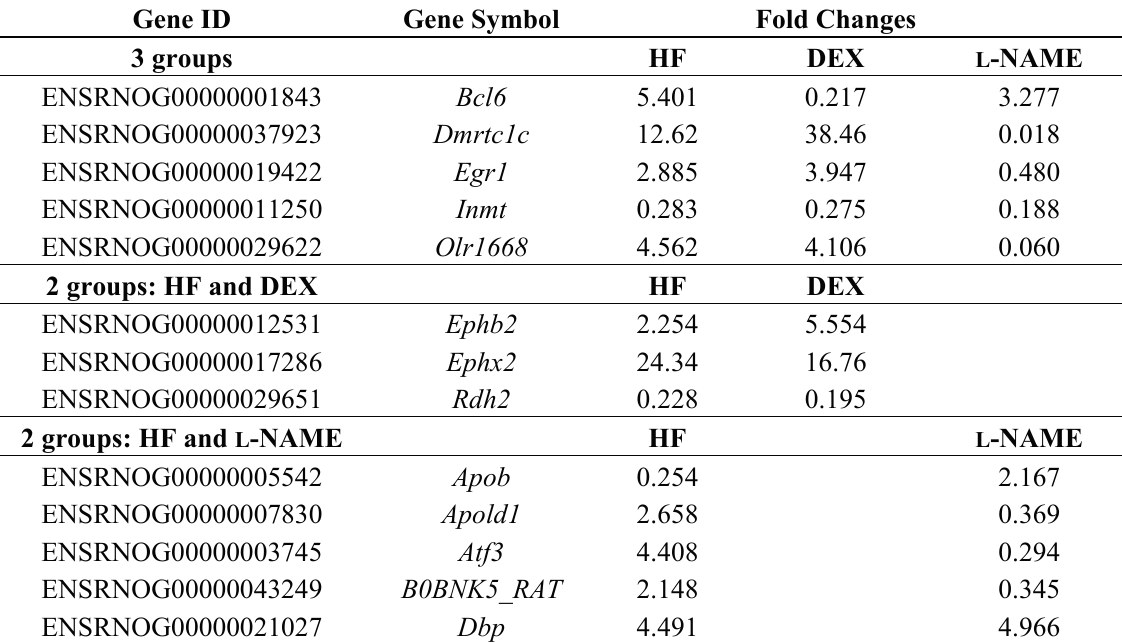
Figure 2. ( A ) Venn diagram depicting unique and shared (overlapping circles) sets of DEGs between high-fructose intake (HF, black circle), dexamethasone treatment (DEX, white circle), and L -NAME treatment (grey circle); ( B ) Confirmatory analysis of kidney gene expression by qPCR in the L -NAME model. Individual gene expression was determined by qPCR and expressed as fold change in log base 2 vs. control and graphed alongside fold change derived from RNA-Seq analysis. Table 1. Changes of shared differential expressed genes (DEGs) between DEX, HF, and L -NAME group in the adult offspring